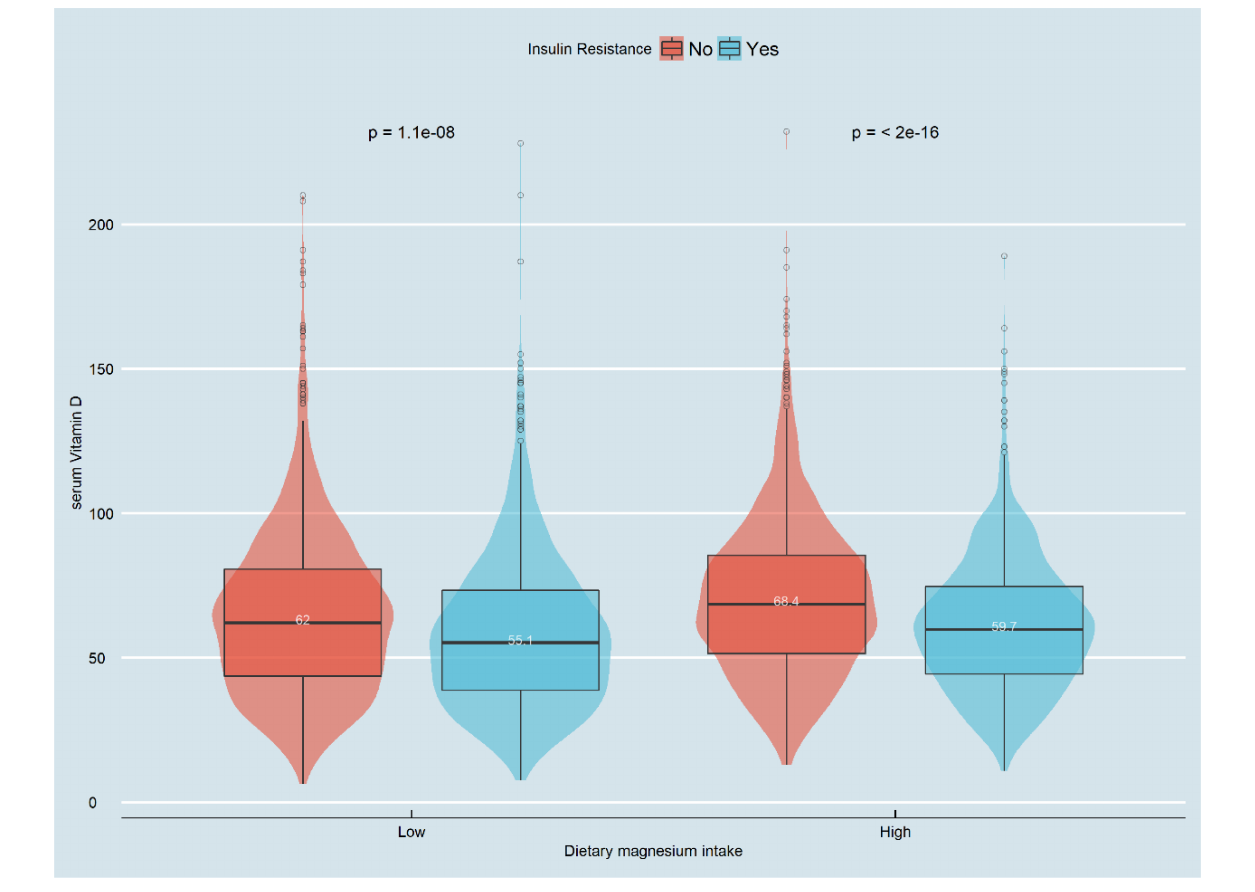
FIGURE 3 | Violin chart of distribution of serum vitamin D in patients with IR group by magnesium intake. In the low-magnesium group, serum vitamin D levels in those with insulin resistance were significantly lower than those without insulin resistance (55.1 vs. 62.0 nmol/L, P < 0.001). In the high-magnesium group, serum vitamin D levels in those with insulin resistance were significantly lower than those without insulin resistance (59.7 vs. 68.4 nmol/L, p <